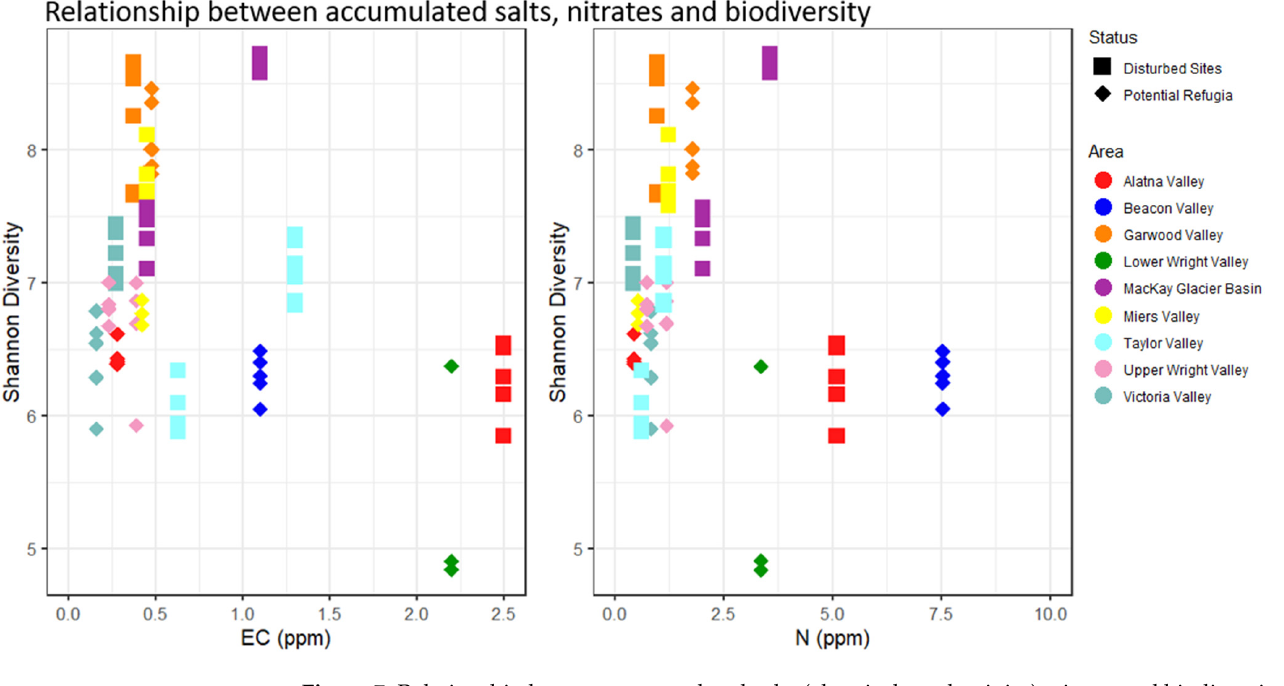
Figure 7. Relationship between accumulated salts (electrical conductivity), nitrate and biodiversity. Individual sample replicates Shannon diversity is displayed in relation to the location’s salt ( left ) and nitrate ( right ) content. Replicates from the same site share the same concentration of salt and nitrate. Diamond-shaped points indicate putative refugia, squares indicate disturbed sites. Colors indicate valley basin of sample origin.